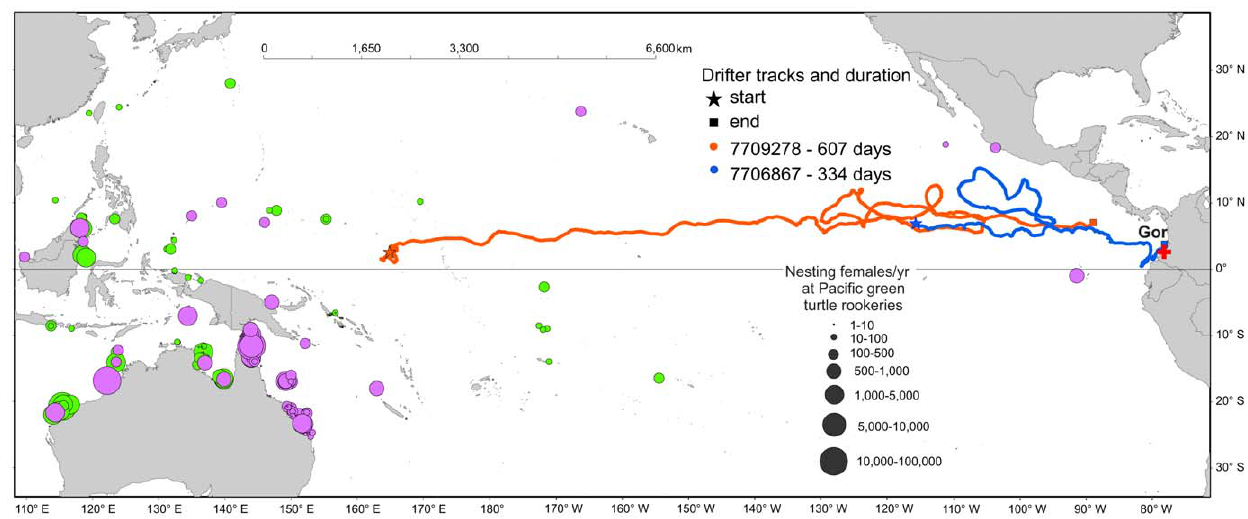
Figure 7. Satellite-tracked drifter buoy trajectories demonstrating potential ocean current pathways linking green turtle breeding areas in the Western Pacific with the Gorgona foraging site. Two drifter tracks initiating on the eastern edge of Western Pacific green turtle habitats leading to areas near the Gorgona study site (red cross). Total duration indicated in the figures. Green turtle rookery locations and abundances derived from IOSEA Marine Turtle Mapping System (http://stort.unep-wcmc.org/imaps/indturtles) and the Marine Turtle Database maintained by C. J. Limpus at Queensland Parks and Wildlife Service, Australia. Purple circles indicate Pacific basin breeding colonies that have been genetically characterized (see Table 2); green circles show populations with no genetic studies. Drifter data from NOAA/AOML Global Lagrangian Drifter Data (http://www.aoml.noaa.gov/envids/gld/krig/parttrk_id_temporal.php).